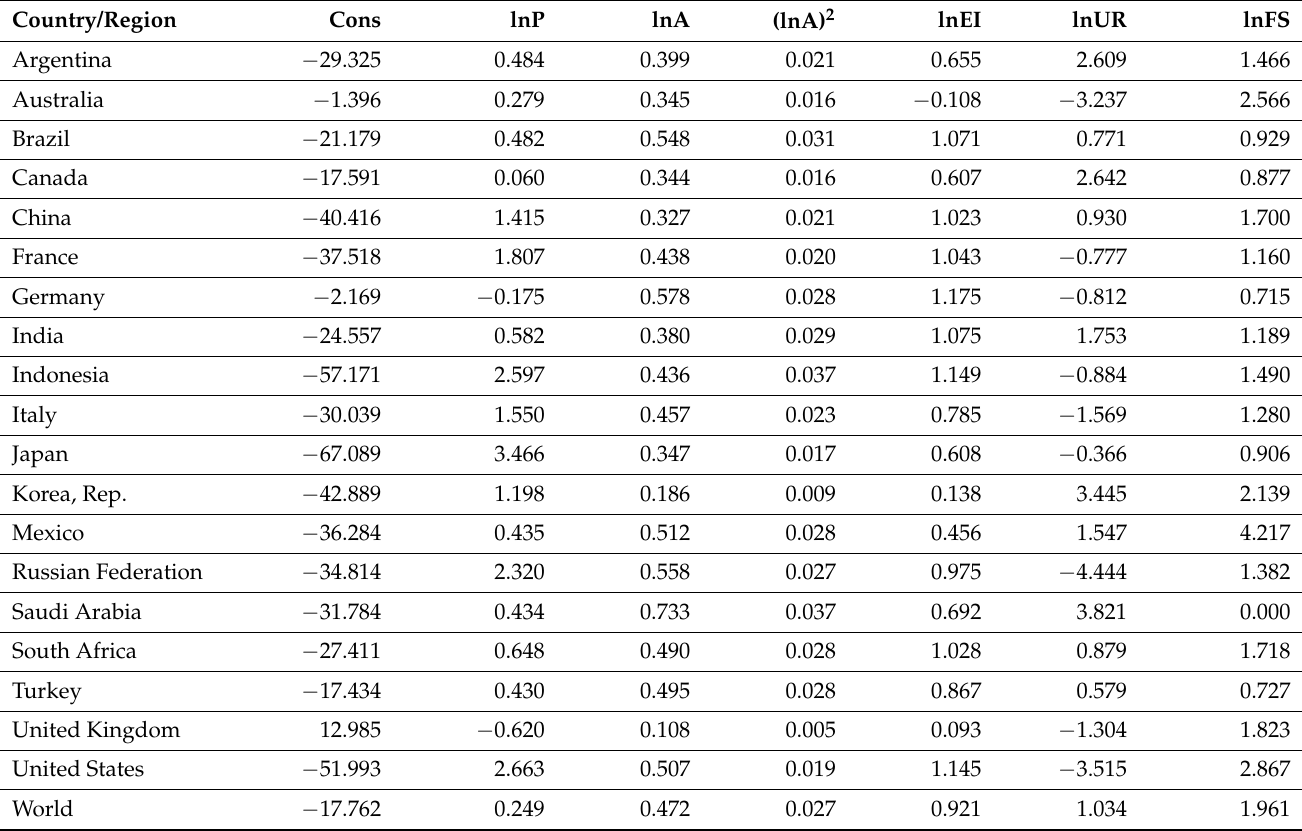
Table 3. Results of PLS analysis based on STIRPAT